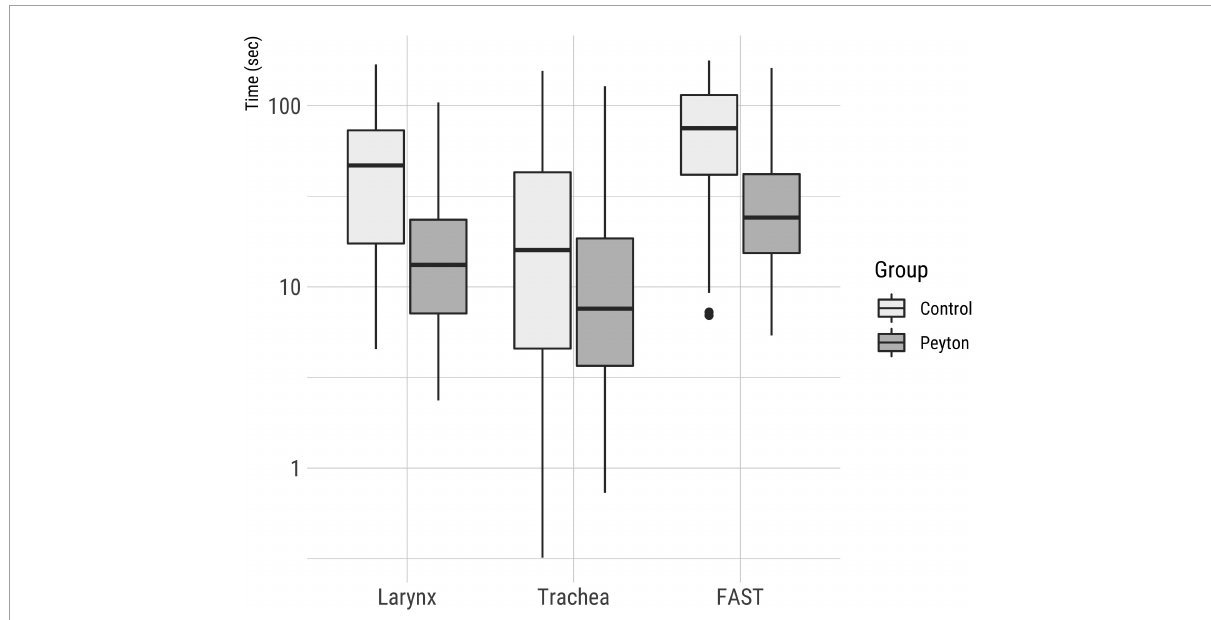
FIGURE3 Total time for successful FAST completion on a logarithmic scale. Intermediate times for visualization of the larynx and the time elapsed between larynx visualization and endotracheal bronchoscope placement are shown.